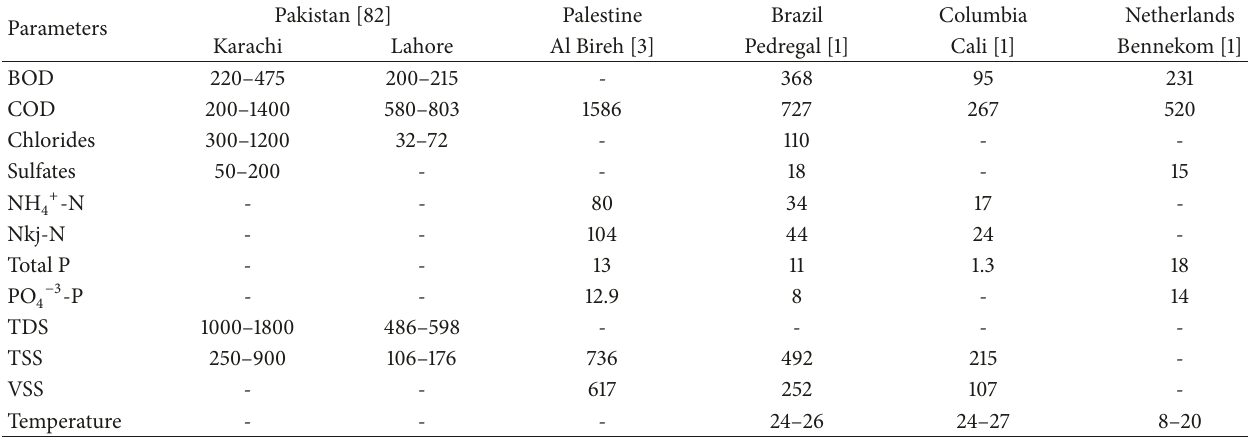
Table 1: Characteristics of sewage in different cities of the world.